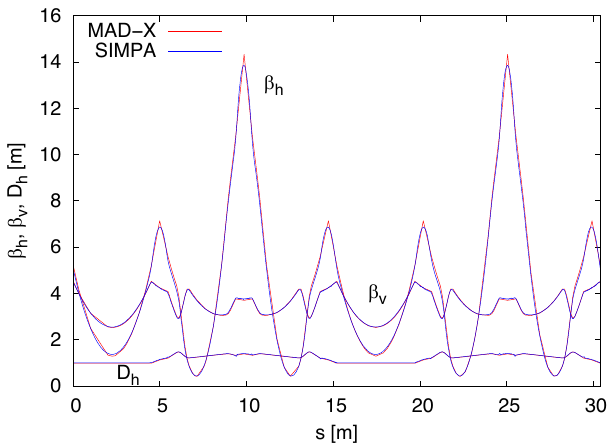
FIG. 3. Comparison of the Twiss functions β h , β v and D h calculated by SIMPA and MAD-X at the working point Q h ¼ 2 . 454 and Q 1 . 416 . The functions are hardly distinguishable v ¼ on the